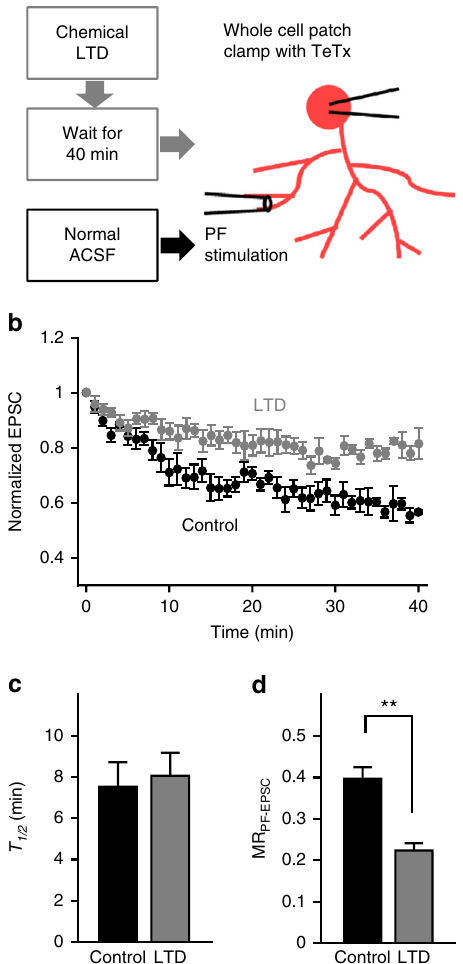
Fig. 1 Reduction in the number of recycling AMPARs during LTD maintenance. a Design of the experiments to investigate AMPAR recycling using TeTx. b Time course of changes in PF-EPSC amplitudes by the application of TeTx through patch pipette. The time right before the start of PF-EPSC reduction was de fi ned as 0 min. Cerebellar slices treated with K-glu ( gray circles , LTD, n = 5) or kept in normal ACSF ( black circles , control, n = 6) were used. PF-EPSC amplitudes are normalized to their level